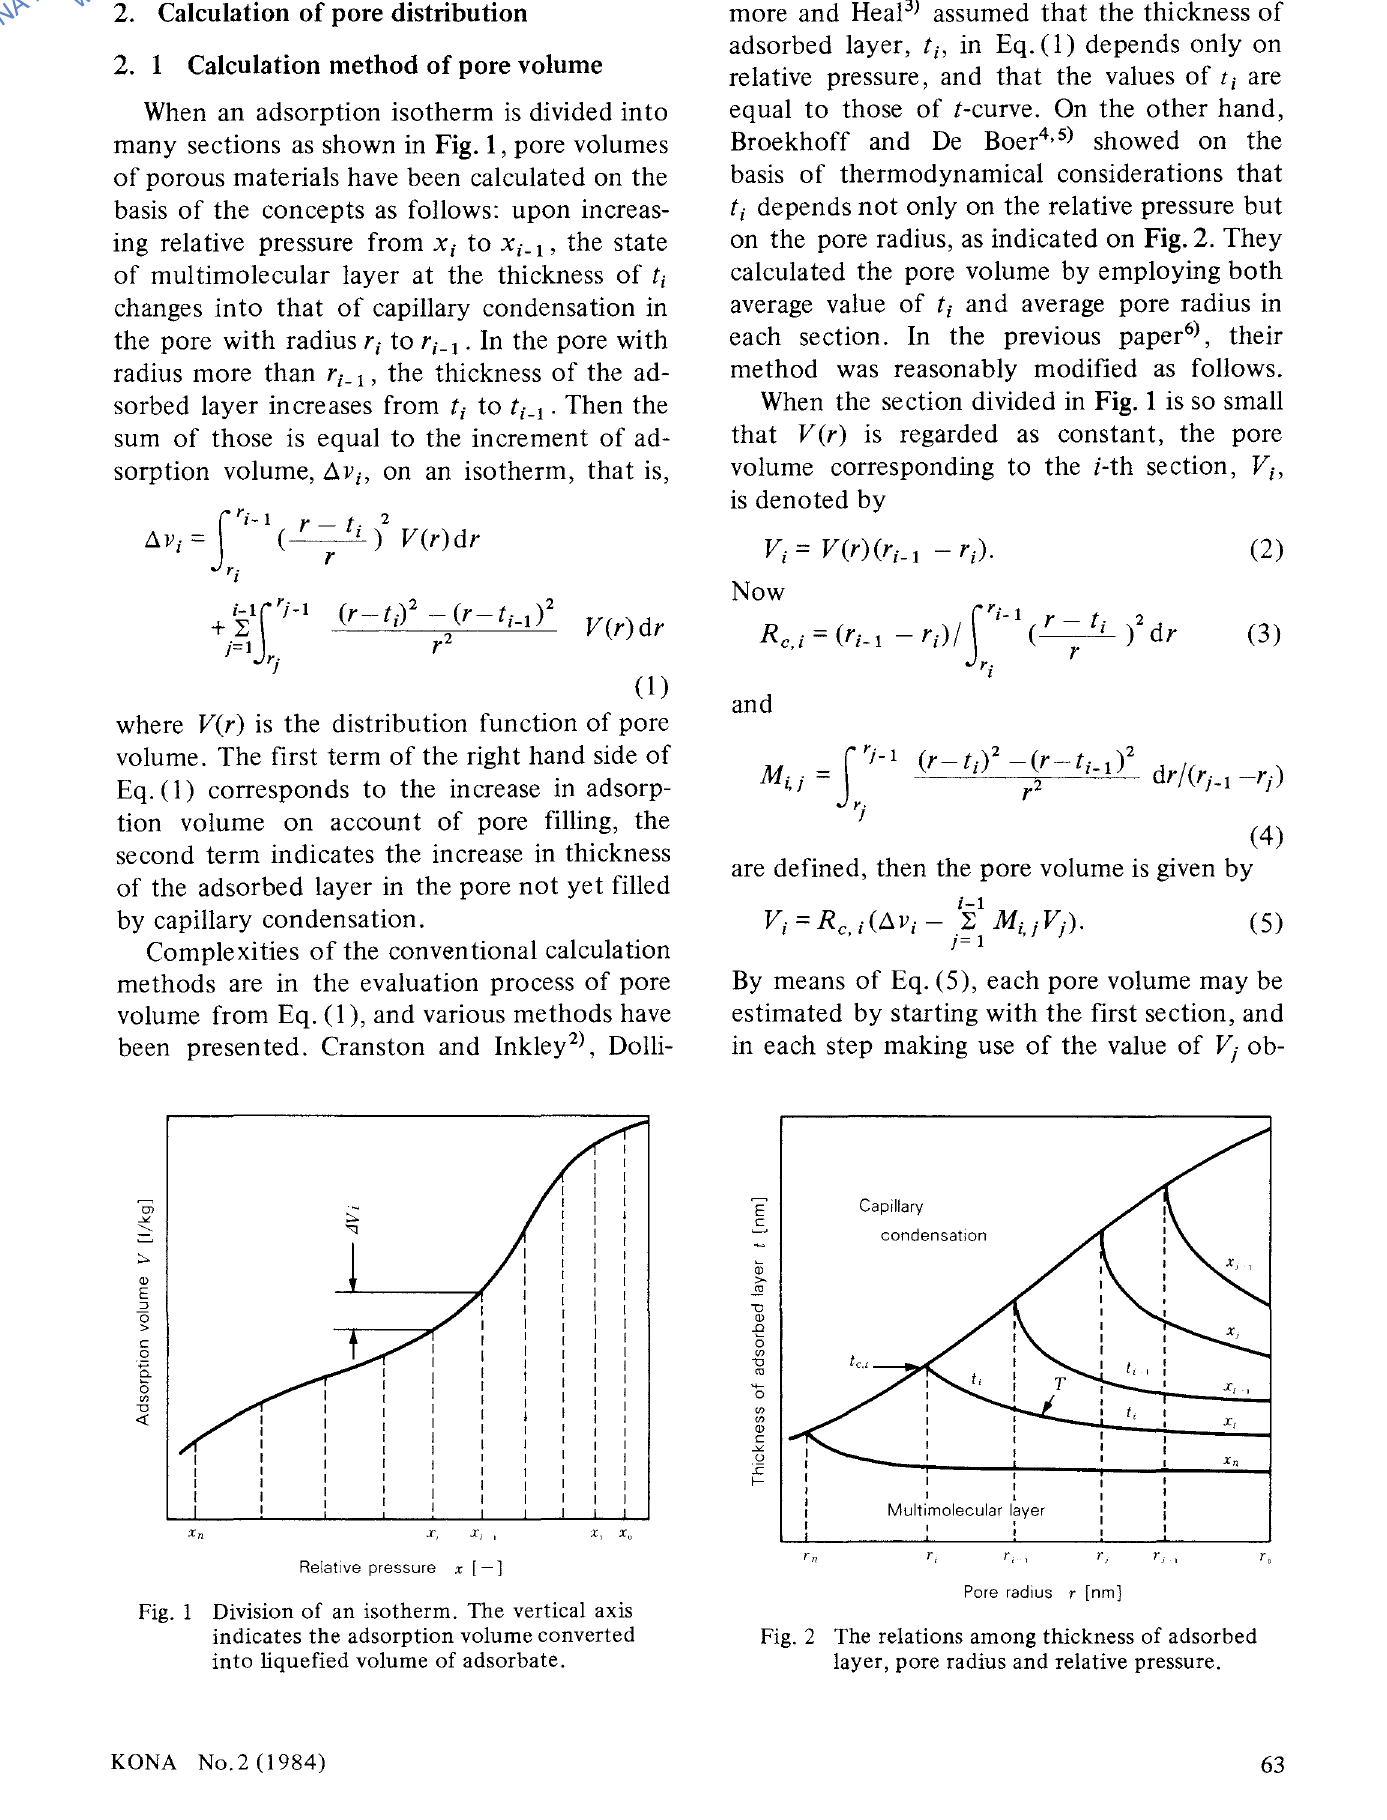
Fig. 1 Division of an isotherm. The vertical axis indicates the adsorption volume converted into liquefied volume of adsorbate.